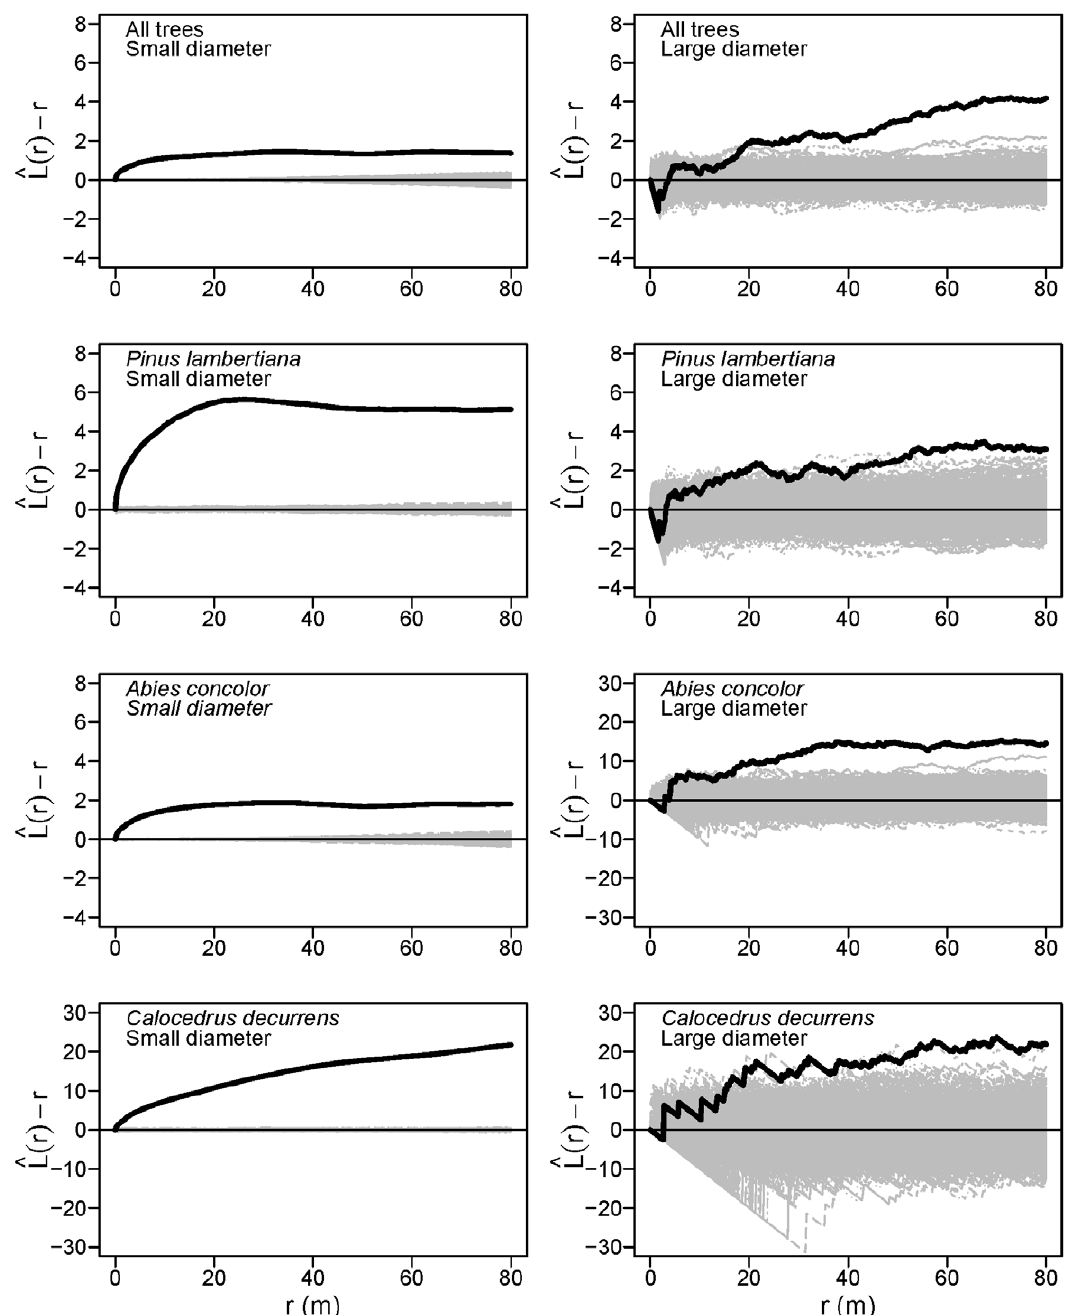
Figure 4. Univariate tree spatial patterns in the Yosemite Forest Dynamics Plot. Solid black lines show the ^ LL ( r ) statistic for the actual patterns, where r is the intertree distance; thin gray lines show ^ LL ( r ) curves for 999 simulations of complete spatial randomness. Positive values indicate spatial clumping and negative values indicate spatial regularity. Large-diameter trees are $ 100 cm dbh; small-diameter trees are , 100 cm dbh. doi:10.1371/journal.pone.0036131.g004 biomass poorly (i.e. [39,40]). Our calculations (Table 3) have been presented to a level of 1 kg/ha to enable comparison of forest dominants with less common and smaller tree species and likely represent an underestimation of whole tree biomass. However, the SD of biomass for principal species in the YFDP is 17% to 32% of the calculated value (Table 3), so the uncertainty of the large- diameter biomass could be larger than the smaller biomass pools.